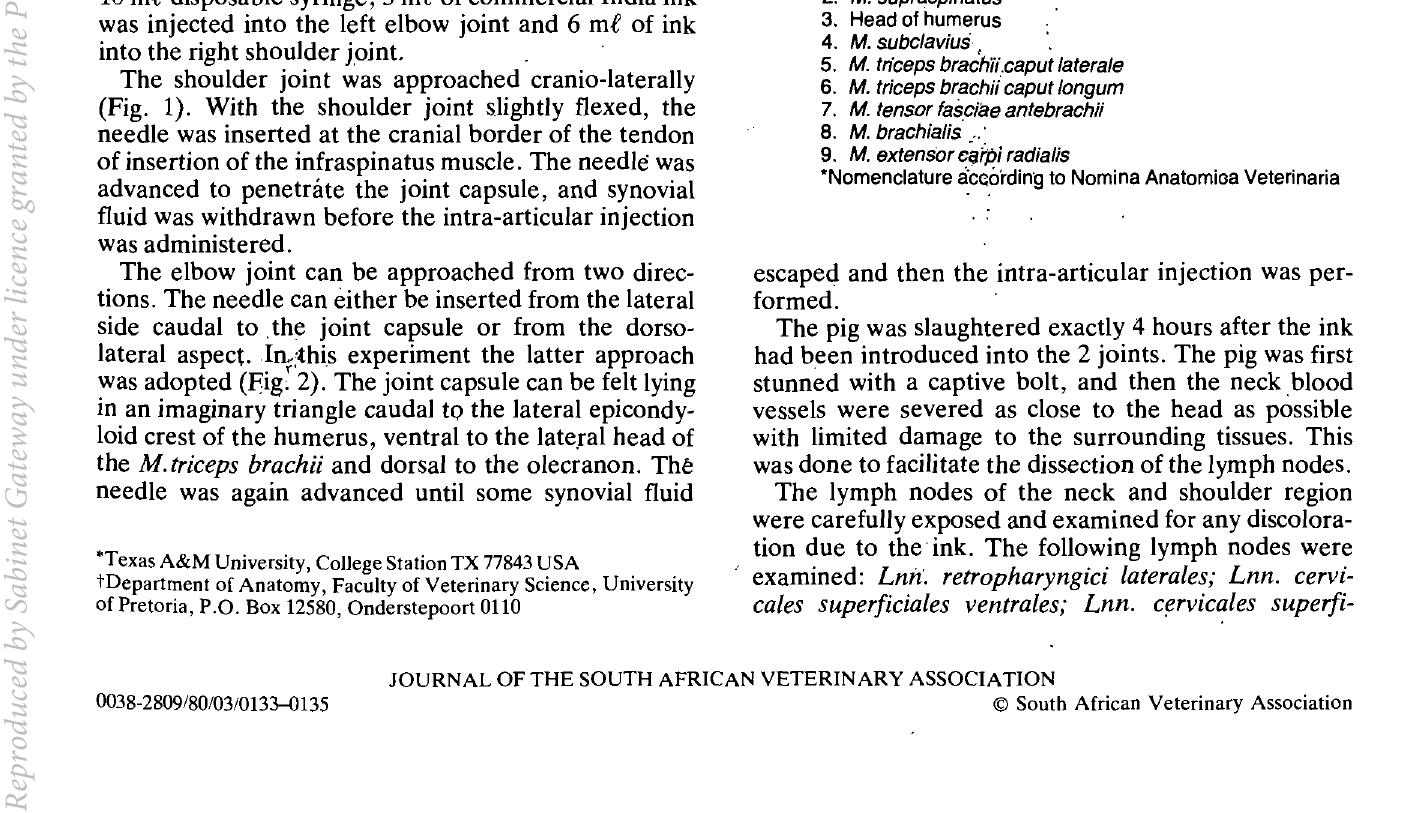
Fig. 1. Lateral surface of the right porcine shoulder (deltoideus and brachiocephalicus muscles removed). 1. Musculus infraspinatus' 2. M. supraspinatus 3. Head of humerus 4. M. subclavius, . 5. M. tn'ceps brachli.caput